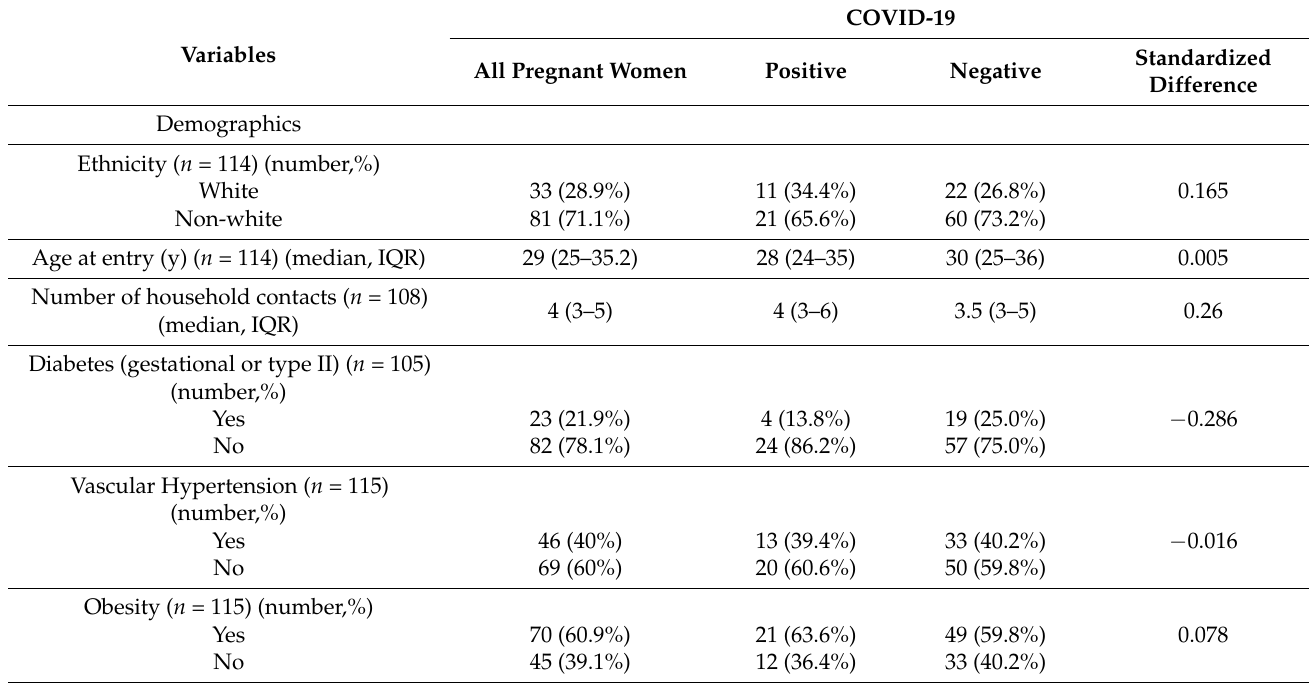
Figure 1. Flowchart of the inclusion and exclusion characteristics of the study population. Table 1. Baseline demographic and clinical characteristics in a cohort of pregnant women screened for SARS-CoV-2 infection at a prenatal care reference center in Rio de Janeiro, March–June